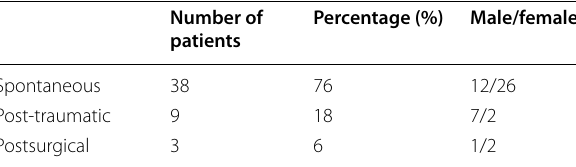
Table 2 Distribution of site of defect and/or leak among the 38 patients Cribriform plate defect and/or